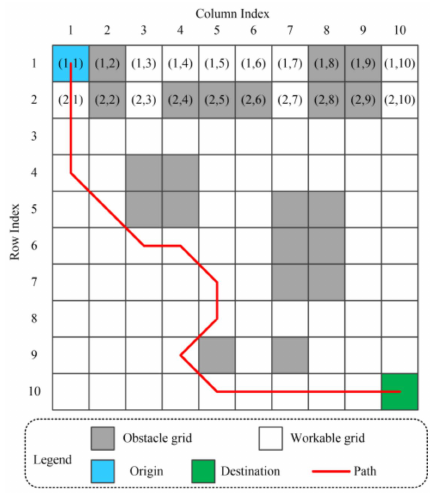
Figure 1. Grid environment map.